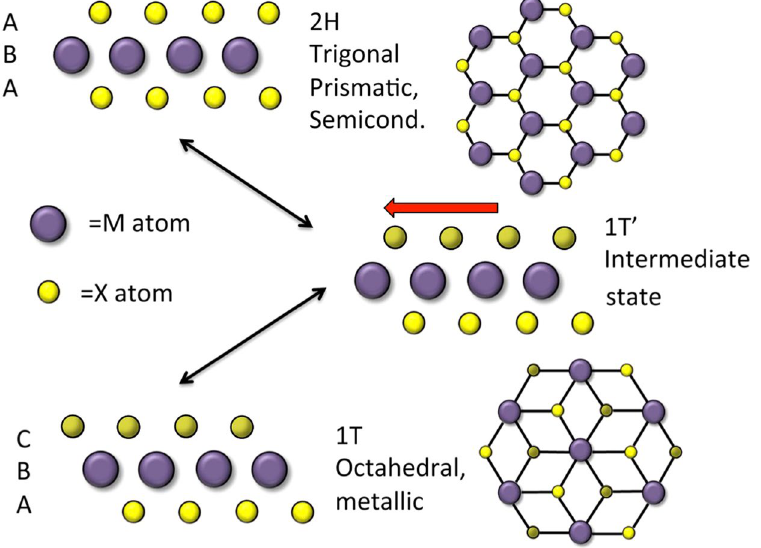
Figure 1. Model of the 2H-1T phase transition in MoX 2 films. The 2H phase is trigonal prismatic and the material is a semiconductor. The 1T phase is octahedral and the material is metallic. The 1T’ phase is an intermediate